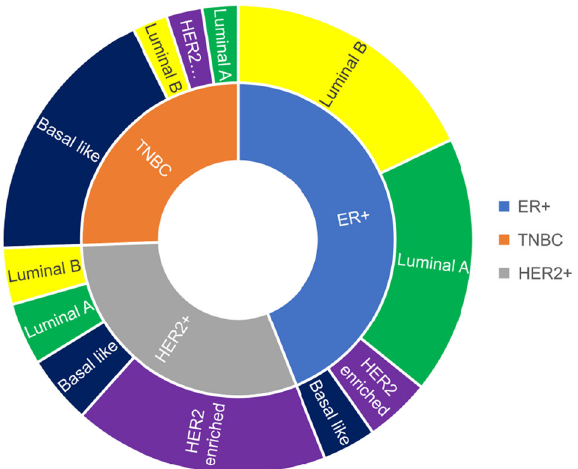
Fig. 1 Intrinsic molecular subtypes of breast cancer. Within each clinical subtype there are multiple molecular subtypes. ER endocrine receptor; TNBC triple negative breast cancer; HER2 Human Epidermal Growth Factor Receptor